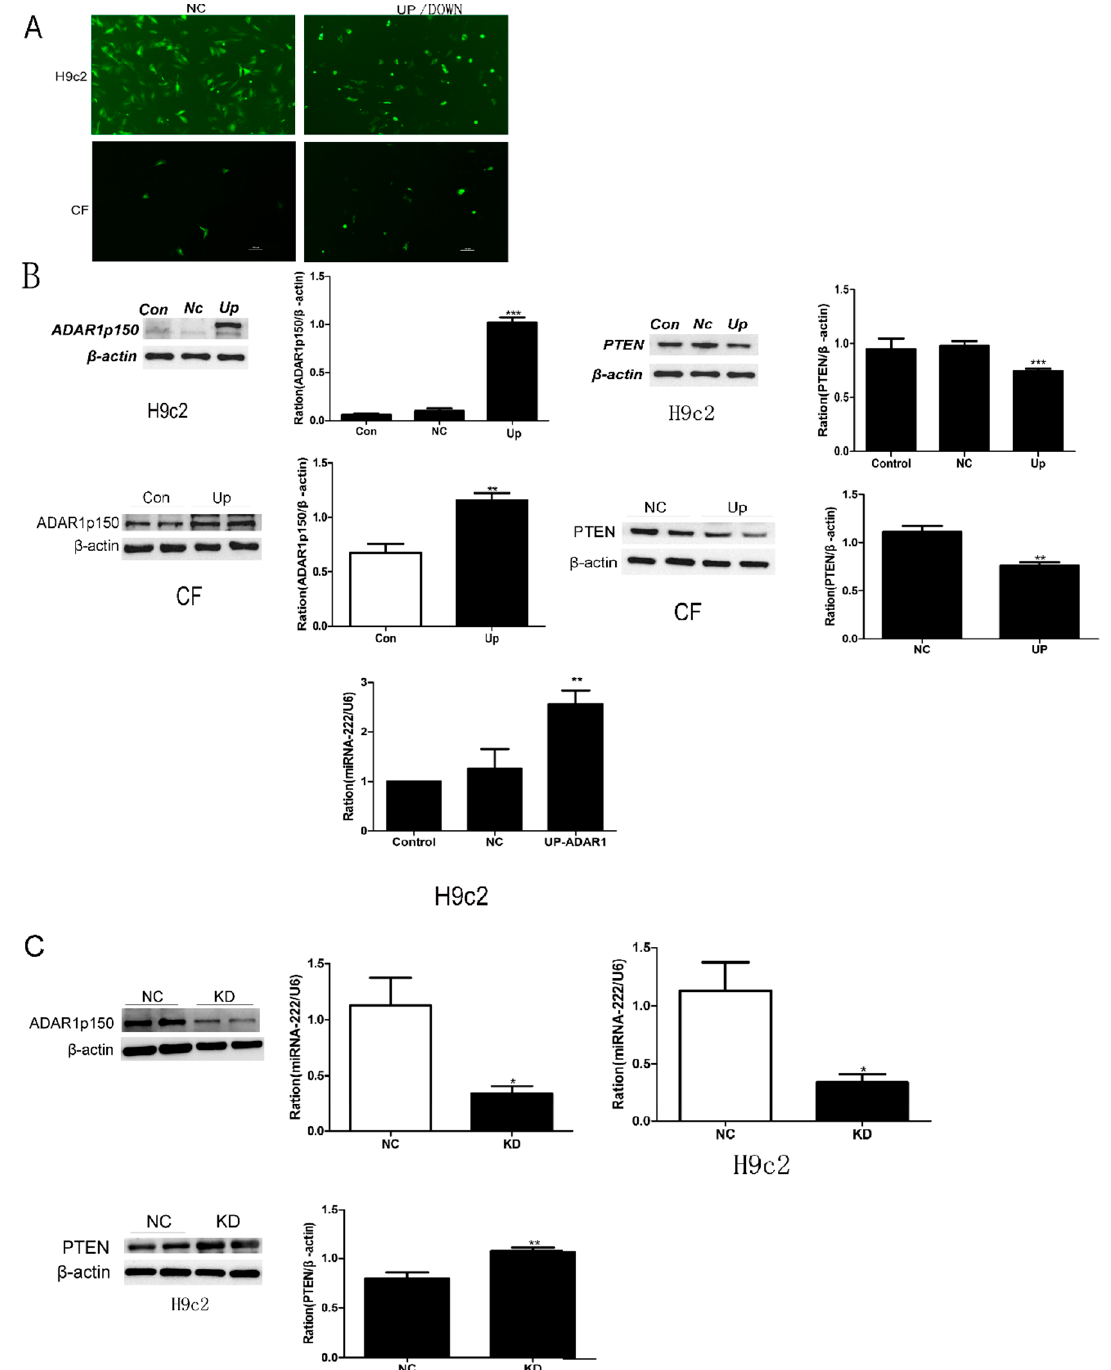
Figure 5. Effects of ADAR1p150 on miRNA-222 synthesis in cultured cells and regulation of phosphatase-and-tensin (PTEN) expression by miRNA-222. ( A ) GFP as a marker protein was detected by immunofluorescence after 48 h transfection in the H9c2 cell line and CFs (cardiac fibroblasts). As shown in the picture, the transduction efficiency was always over 80%. ( B ) After confirming that ADAR1p150 high expression transfection was successful, miRNA-222 and PTEN were quantitatively or relatively quantified. ( C ) After inhibiting the expression of ADAR1P150, miRNA-222 and PTEN were quantitatively or relatively quantified. Data represent the mean ± SEM from the control (Con)and infected groups, negative control (NC)knocked down (KD), * p < 0.05, ** p < 0.01, *** p < 0.001.